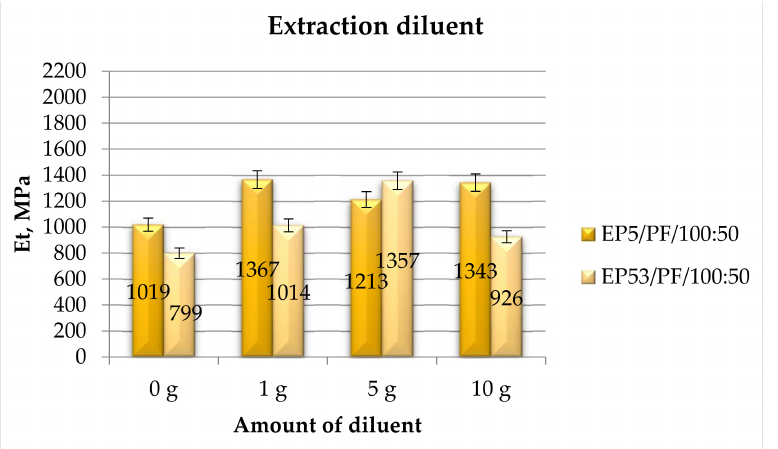
Figure 19. Tensile modulus calculated for Epidian 5 and Epidian 53 epoxy compounds as a function of the amount of extraction